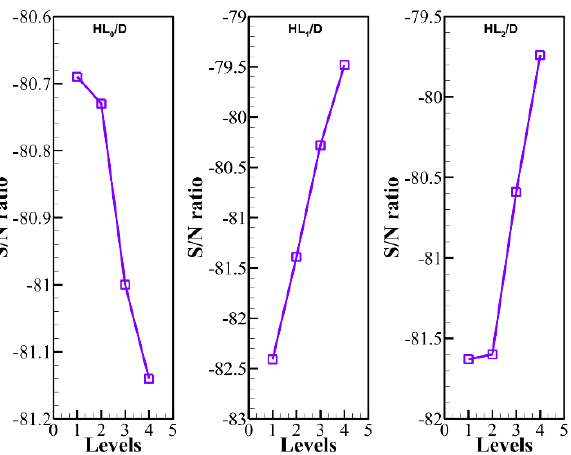
Figure 4. S/N ratios at the levels of the optimum case were as following: HL 0 / D = 1, HL 1 / D = 4, and HL 2 / D = 4.